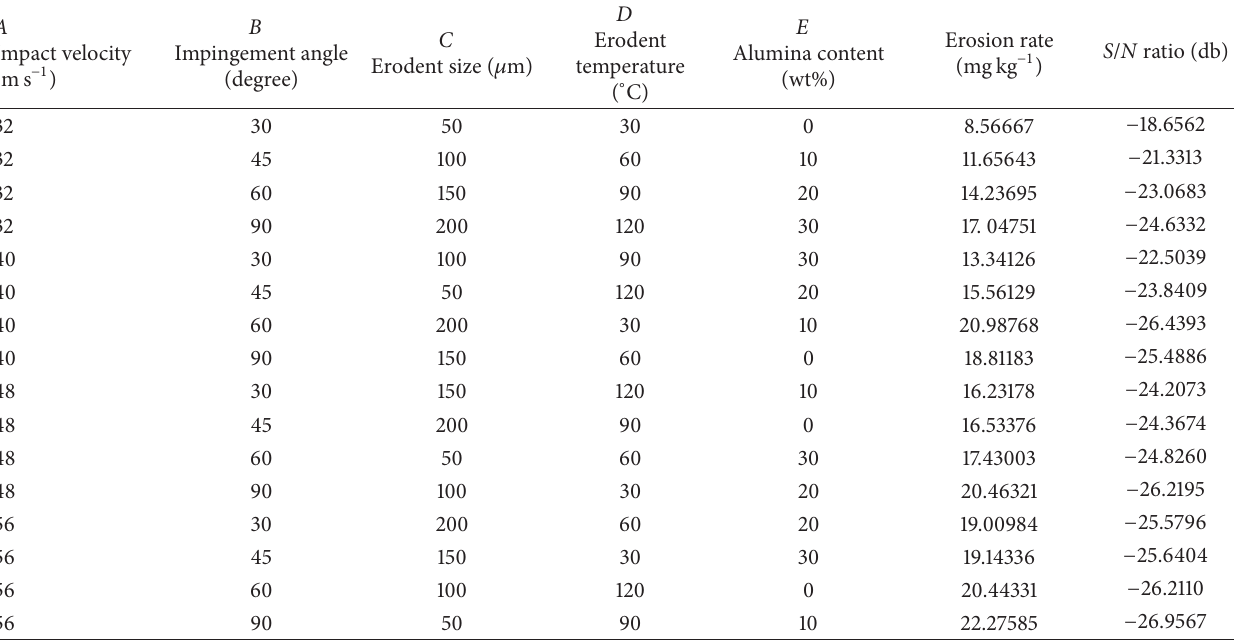
Figure 7: Effect of impact velocity for different (a) impingement angle and (b) erodent size. Table 6: Experimental design using L orthogonal array and the wear test 16